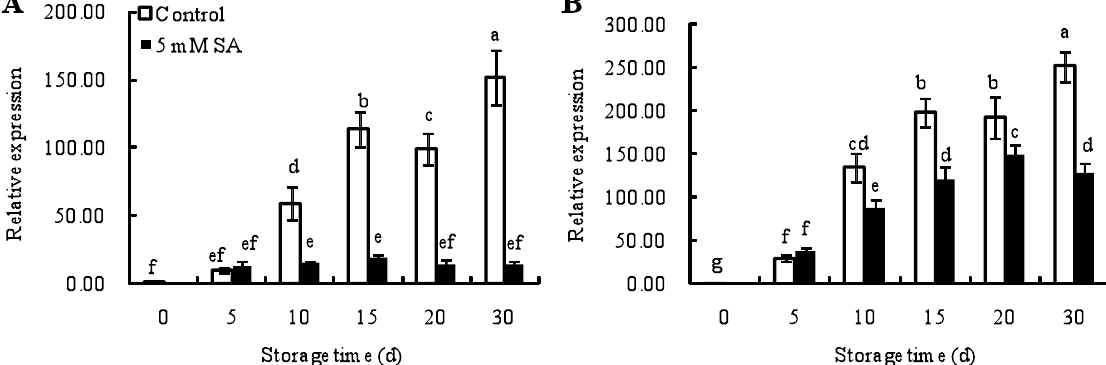
Fig. 5: Changes of relative expression level of PPO1 (A) and PPO5 (B) genes of peel in ‘Huangguan’ pear by SA treatment during cold storage. Values are mean ± SE of three replicates. Different letters represent significant differences at P = 0.05.